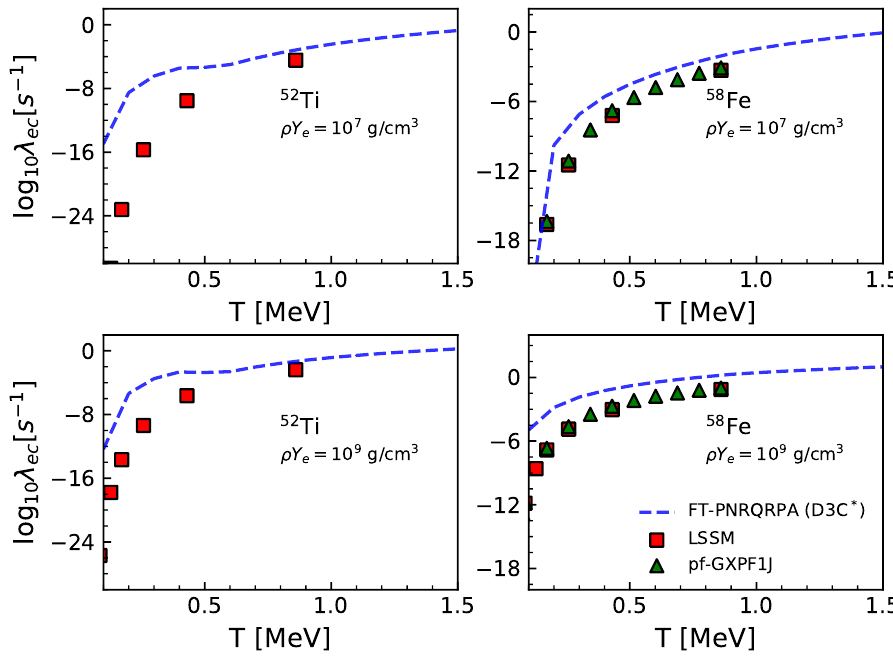
Figure 1. Electron capture rates λ ec for 52 Ti and 58 Fe for stellar densities ρ Y e = 10 7 and 10 9 g / cm 3 . The FT-PNRQRPA results (blue dashed line) with D3C ∗ interaction are shown together with the LSSM re- sults (red squares) [6], and the shell-model results based on the pf-GXPF1J interaction (green triangles) [7,